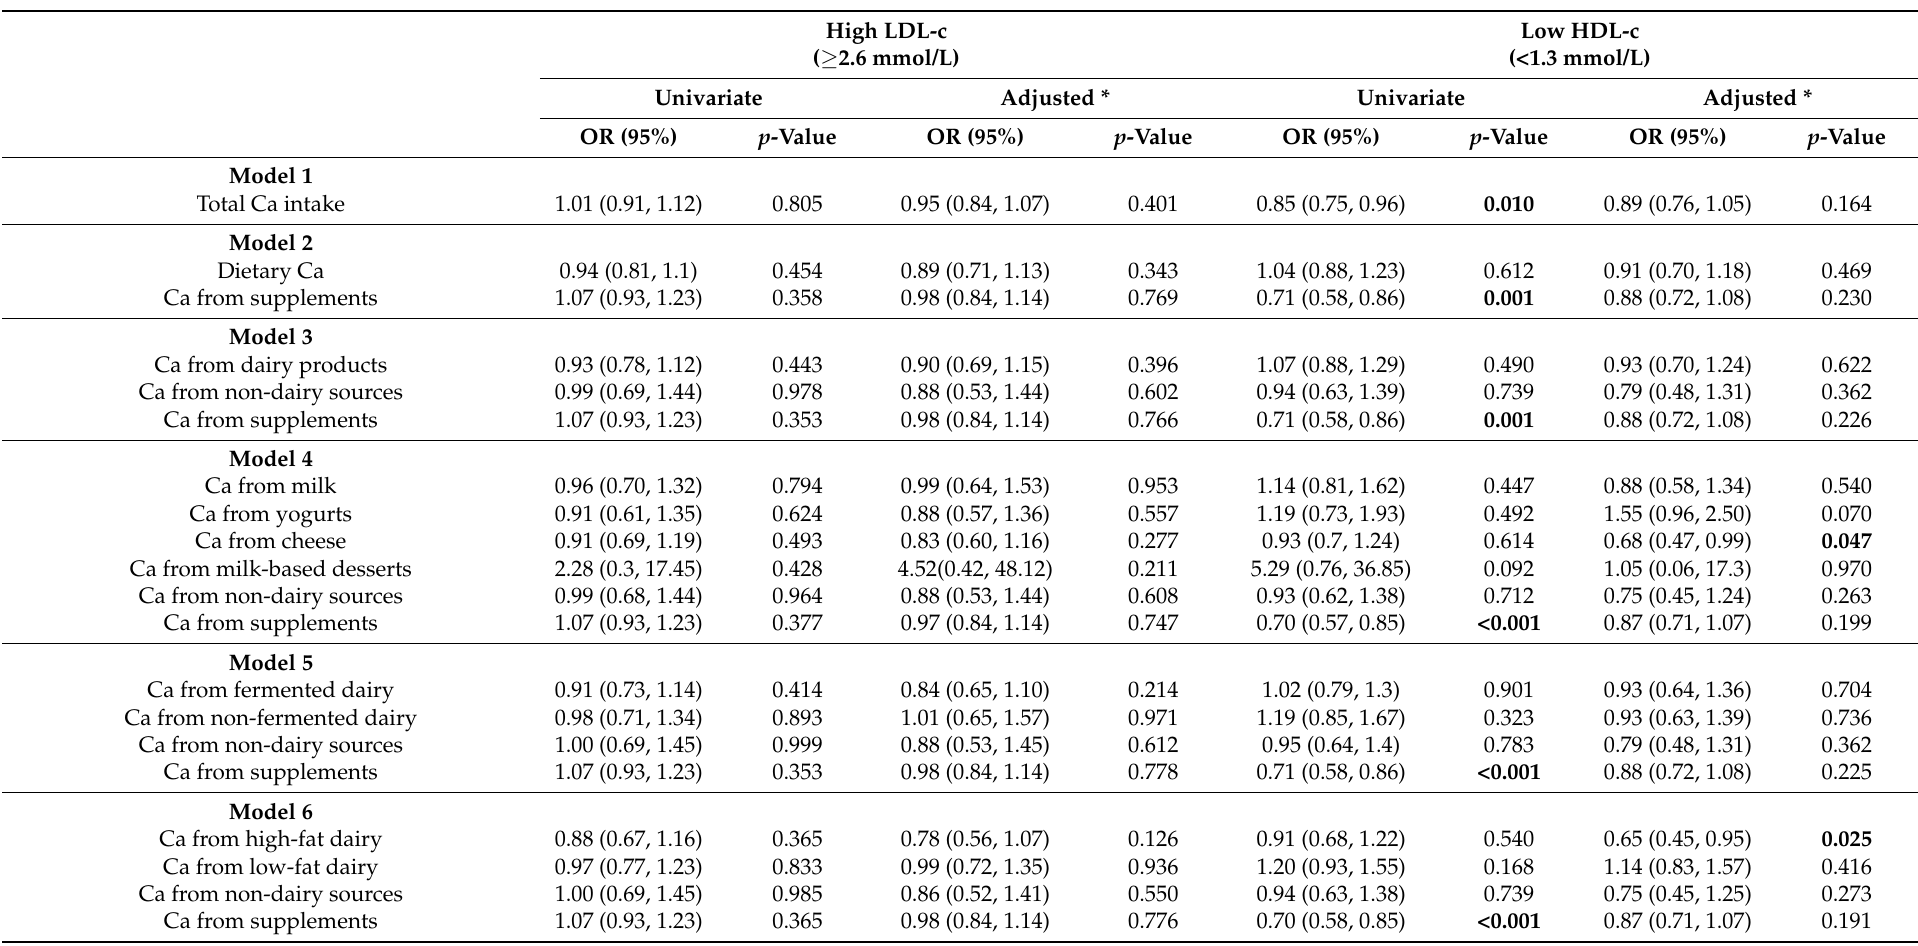
Table 5. Univariate and adjusted ORs and 95 CIs for having high LDL-c and low HDL-c levels per 300 mg increase in total calcium intake and calcium from different